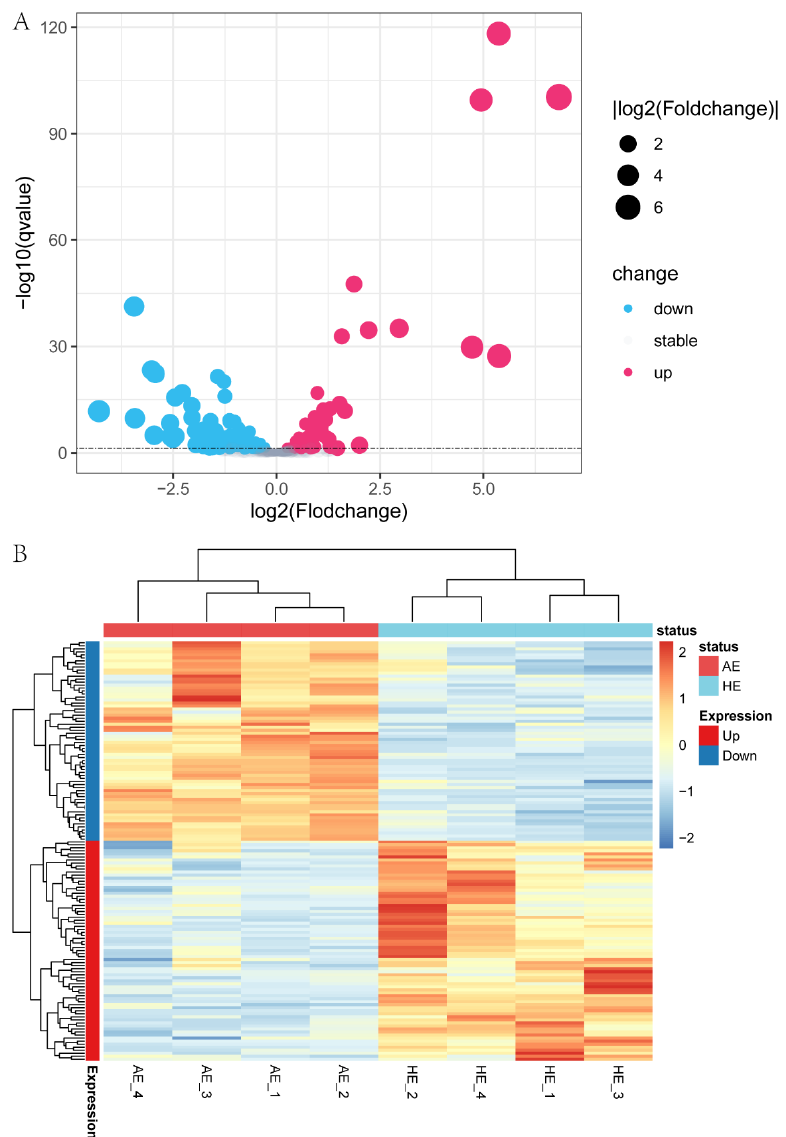
Figure 4. Differential expression of miRNA in arresting endometrium (AE) and healthy endometrium (HE) samples. ( A ) Each dot represents one miRNA for the differentially expressed miRNAs (DEMs) in the porcine endometrium. The drop size represents the fold change gradient of DEMs expression level. The three different colors represent upregulation, downregulation, and stable expression. ( B ) The hierarchical clustering heatmap showed DEMs expression status in AE and HE. The color scale gradually increases from − 2 (blue, low miRNA expression level) to 2 (red, high miRNA expression